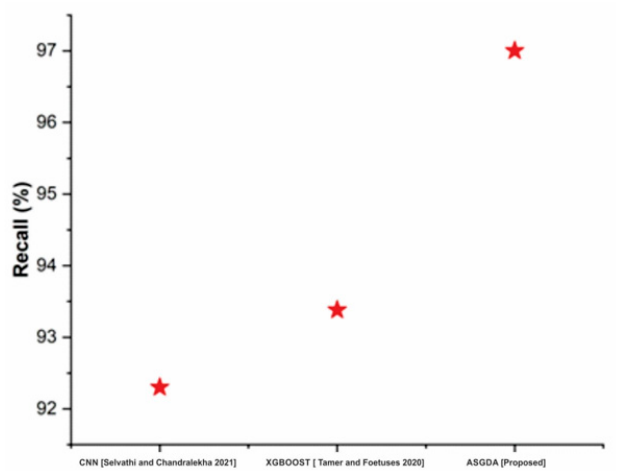
Figure 9. Comparison of precision with the traditional and proposed method [42,43].